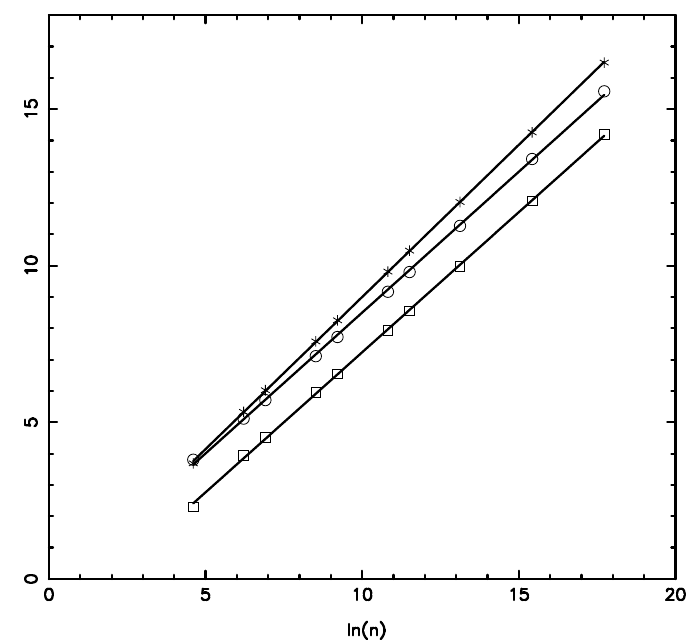
( ν )) vs. ln( n ) . Circle: Π n